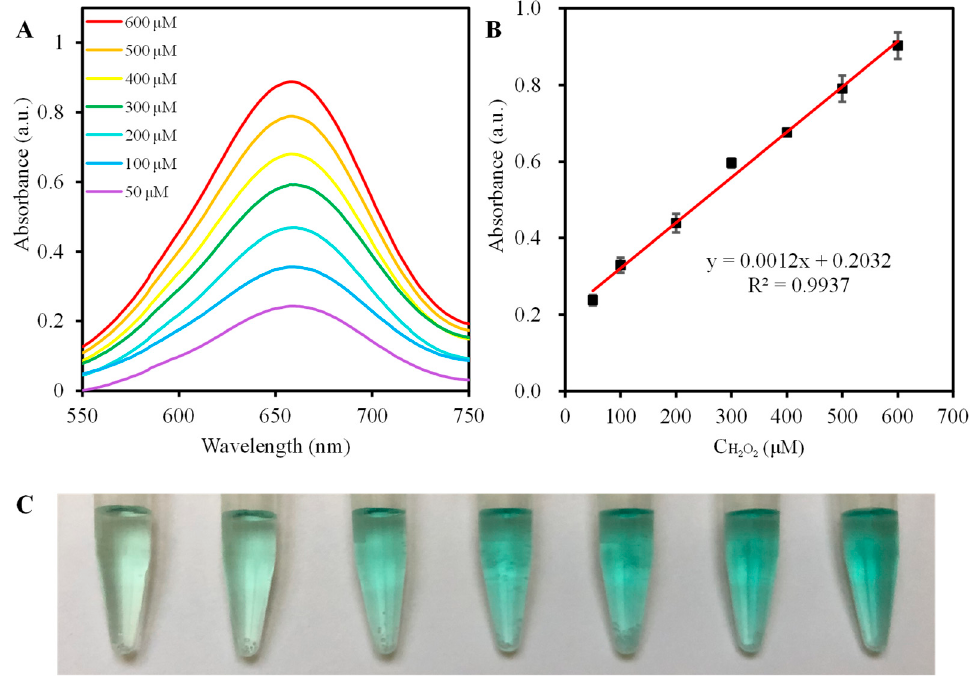
Figure 4. ( A ) The UV-Vis absorption spectra of VB6-TMB system upon adding different concentrations of H 2 O 2 (50.0–600.0 μ M, from bottom to top); ( B ) Calibration plot of the absorbance versus the concentrations of H 2 O 2 under the optimal conditions; ( C ) The corresponding digital photograph. The error bars represent the standard deviations of three independent